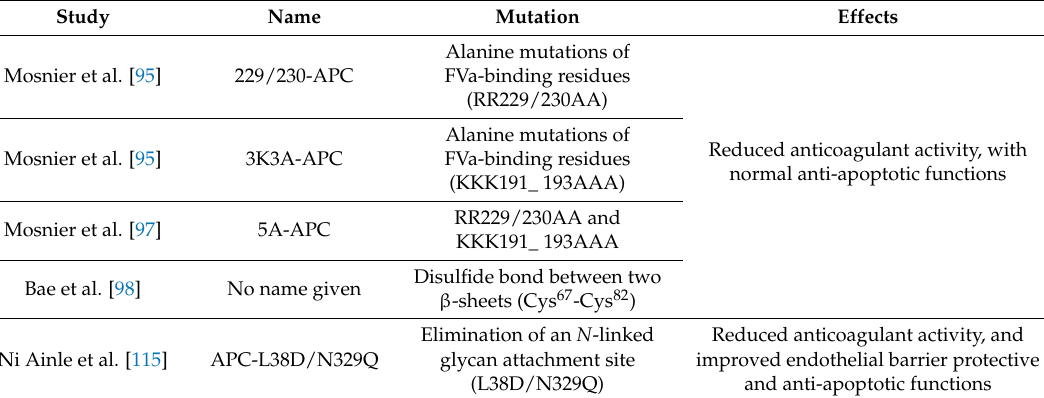
Table 4. Notable examples of mutational studies for